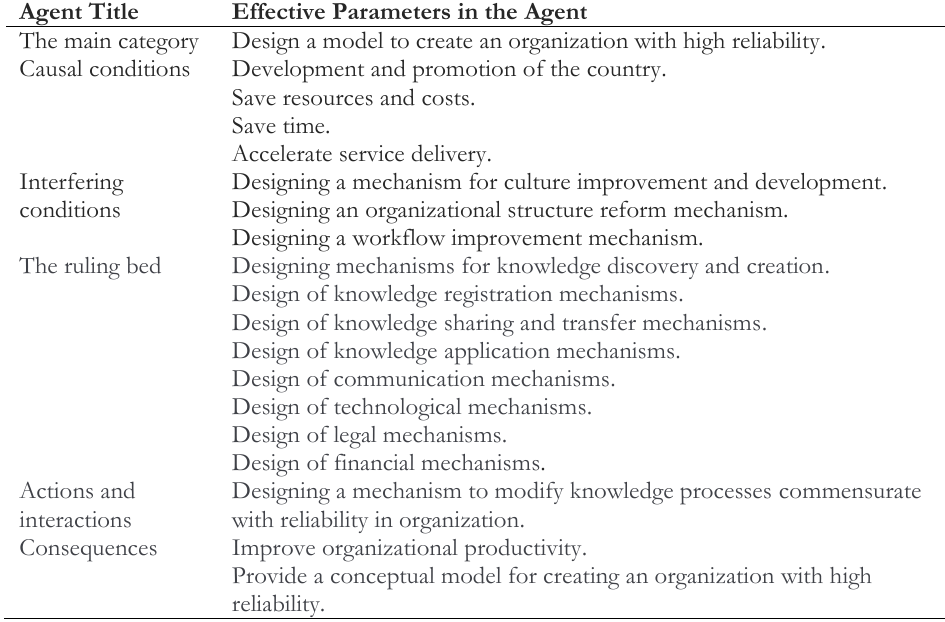
Table 3. Description of the final theory (conceptual framework).